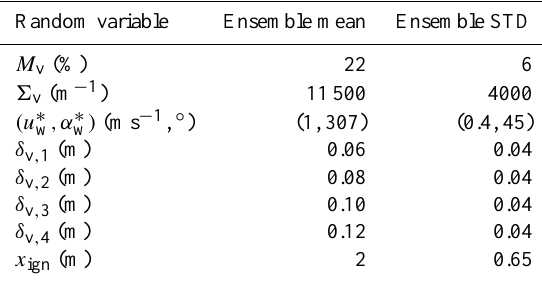
Table 4. Statistical properties of the forecast ensemble in the con- trolled grassland fire